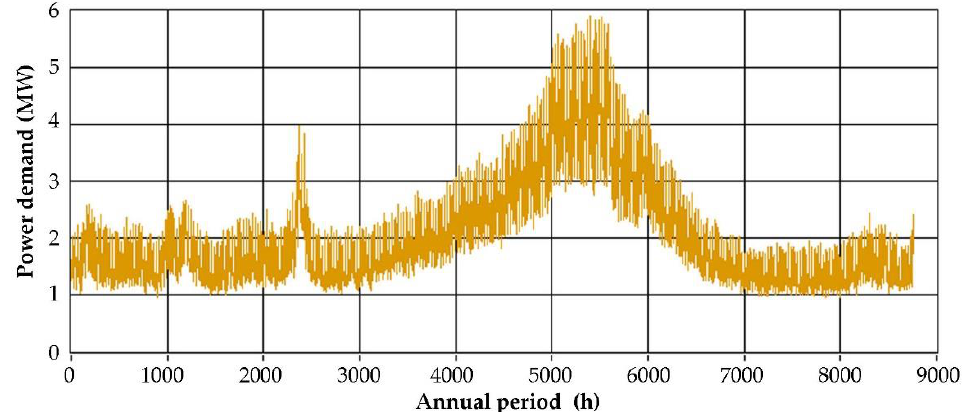
Figure 4. Annual power demand fluctuation on Sifnos in 2015.